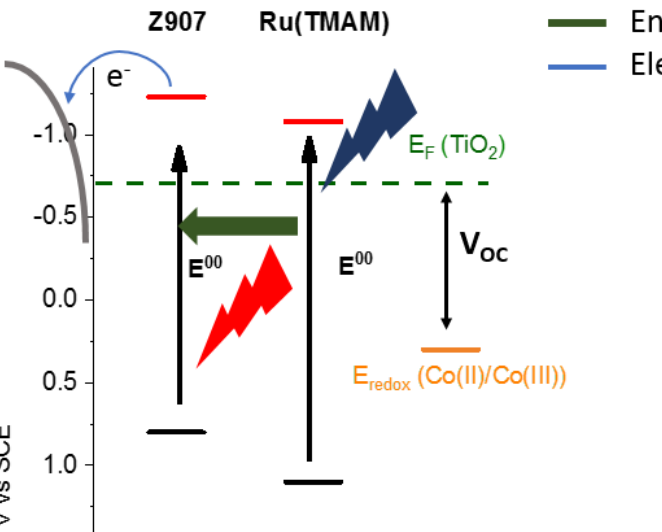
Figure 11. Energy level diagram involving the ground and the lowest excited states of 4 and the resulting energy and electron transfer pathways. Absorption of higher energy photons is realized by the RuTMAM unit that funnels energy to Z907 , which undergoes photoinduced injection. Supplementary Materials: Additional spectroscopic, electrochemical and photoelectrochemical measurements are available online at www.mdpi.com/xxx/s1.